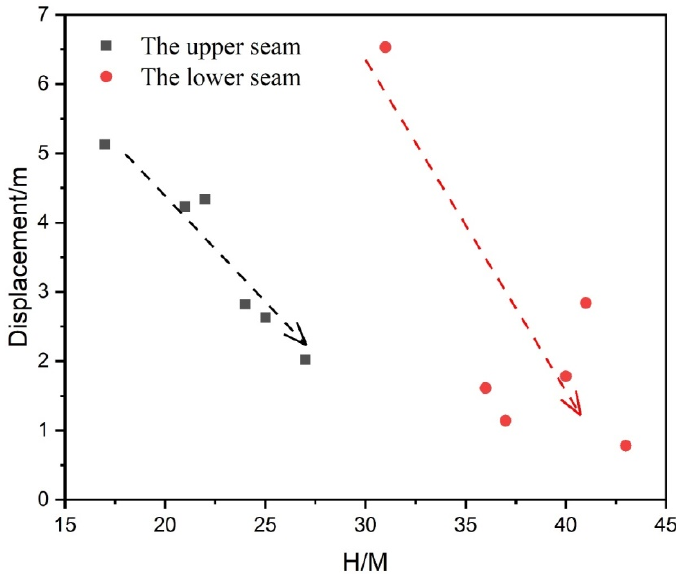
Figure 14. The relationship between H/M and subsidence displacement.